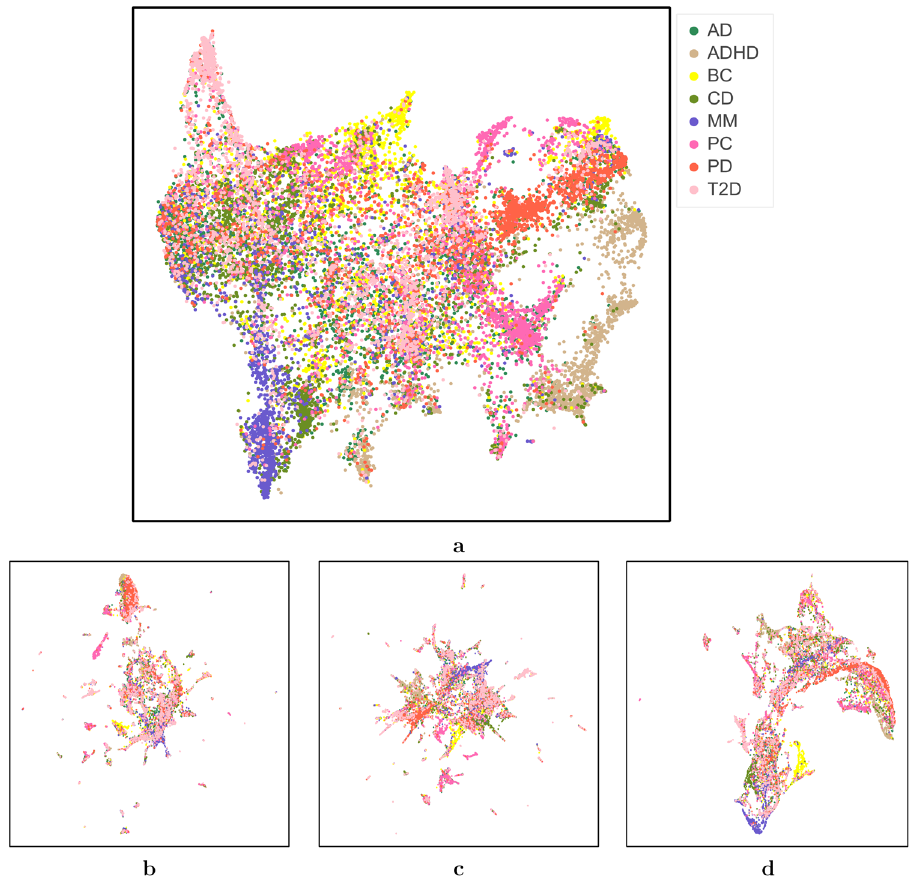
Fig. 2 Uniform manifold approximation and projection (UMAP) encoding visualization. a ConvAE 1-layer CNN; b SVD-RawCount; c SVD- TFIDF; d Deep Patient. AD Alzheimer ’ s disease, ADHD attention de fi cit hyperactivity disorder, BC breast cancer, CD Crohn ’ s disease, MM multiple myeloma, PC prostate cancer, PD Parkinson ’ s disease, T2D type 2